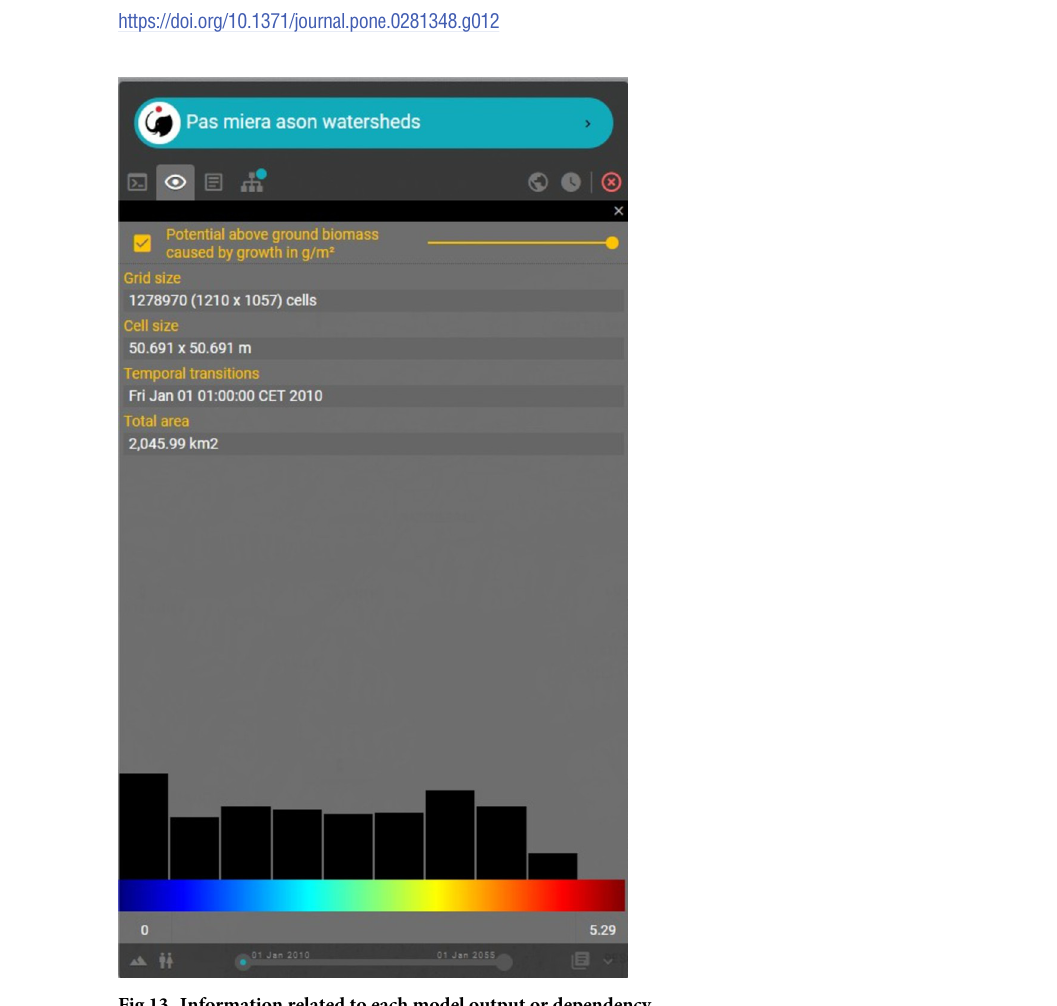
Fig 12. Output of the model “Potential above ground biomass caused by growth” and its model dependencies. Reprinted from OpenLayers (https://openlayers.org) under a 2-Clause BSD, with permission from OpenLayers, original copyright 2005 to present.